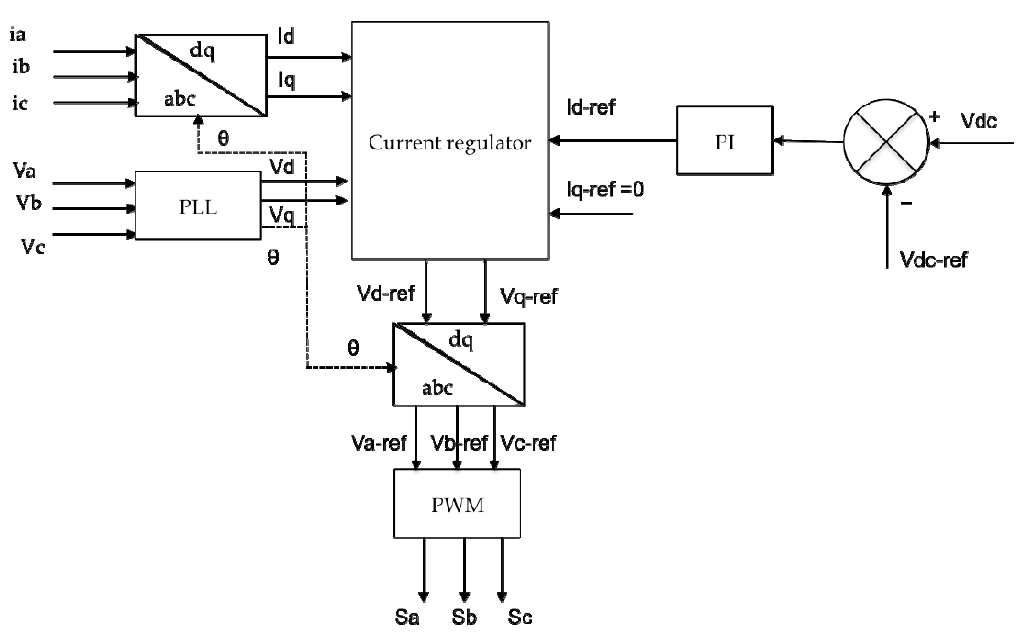
Figure 6. Control diagram of the grid ‐ side inverter, PLL: phase ‐ locked loop.